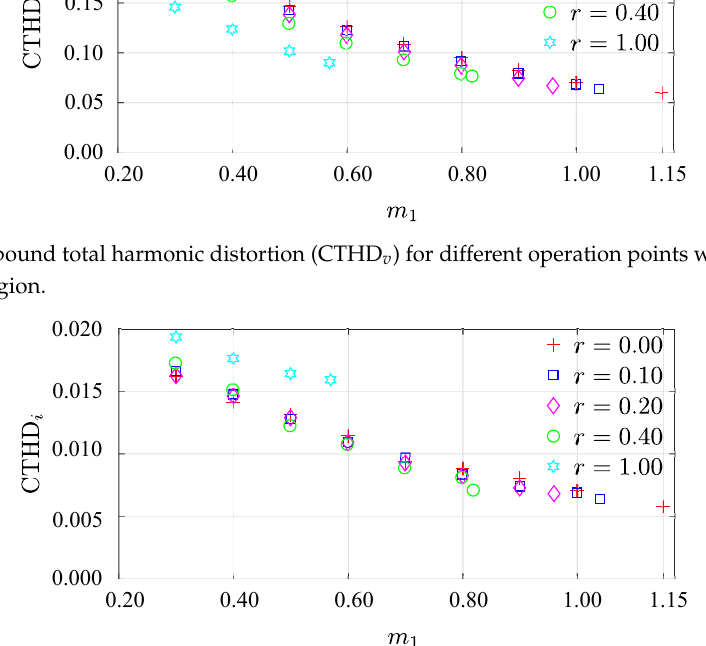
Figure 9. CTHD i for different operation points within the linear modulation